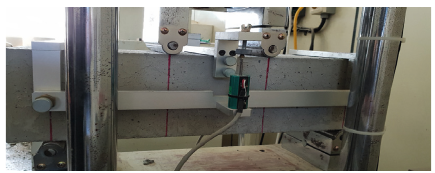
Figure 4: Setting of the specimen in UTM.